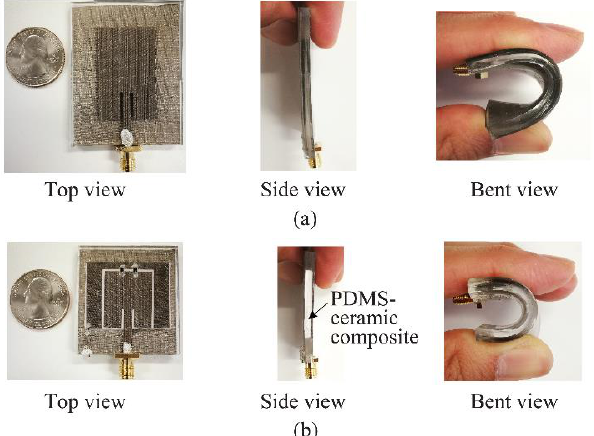
Figure 7. Photographs of the fabricated PDMS-embedded conductive fabric antennas ( a ) with pure PDMS; ( b ) with PDMS-ceramic composite [60].